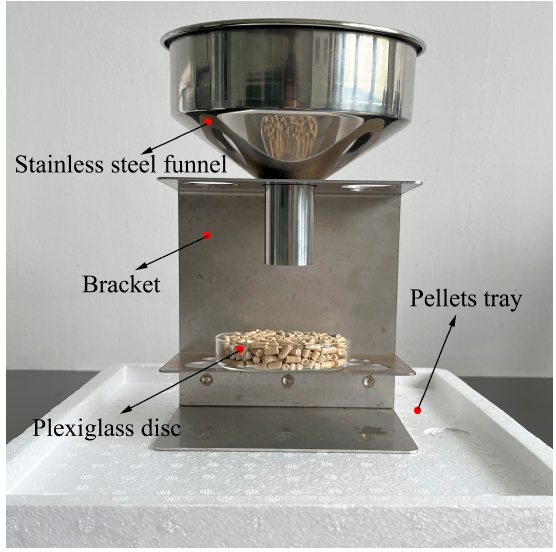
Figure 5. The angle of repose measuring device.